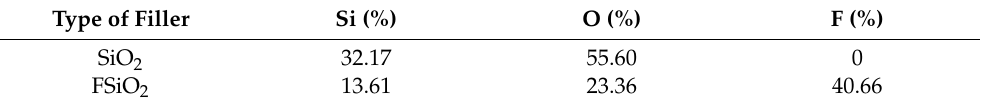
Table 1. Proportion of elements on SiO 2 surface before and after fluorination.